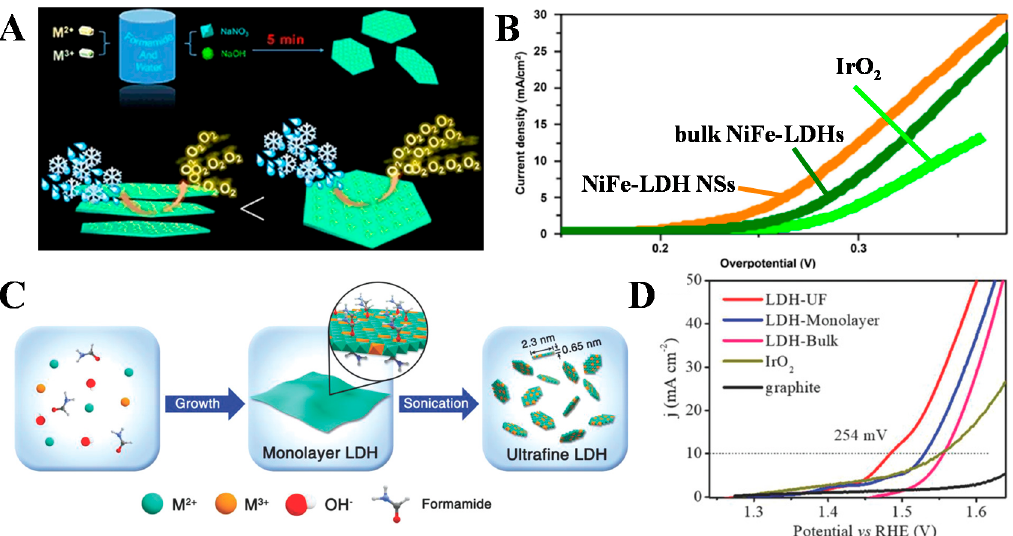
Figure 10. ( A ) Schematic illustration for the formation of ultrathin single-unit-cell-thick LDH NSs; ( B ) LSV curves for the ultrathin single-unit-cell NiFe-LDH NSs, bulk NiFe-LDHs, IrO 2 nanoparticles at 1600 rpm in 0.1 M KOH solution [168]. Copyright © Tsinghua University Press and Springer-Verlag GmbH Germany 2017. ( C ) Synthetic strategy used for the synthesis of ultrafine monolayer LDH nanosheets; ( D ) OER polarization curves for LDH-Bulk, LDH-Monolayer, LDH-UF, IrO 2 , and graphite, respectively at 1600 rpm in 1 M KOH solution [170]. Copyright © 2018 WILEY-VCH Verlag GmbH & Co. KGaA, Weinheim.